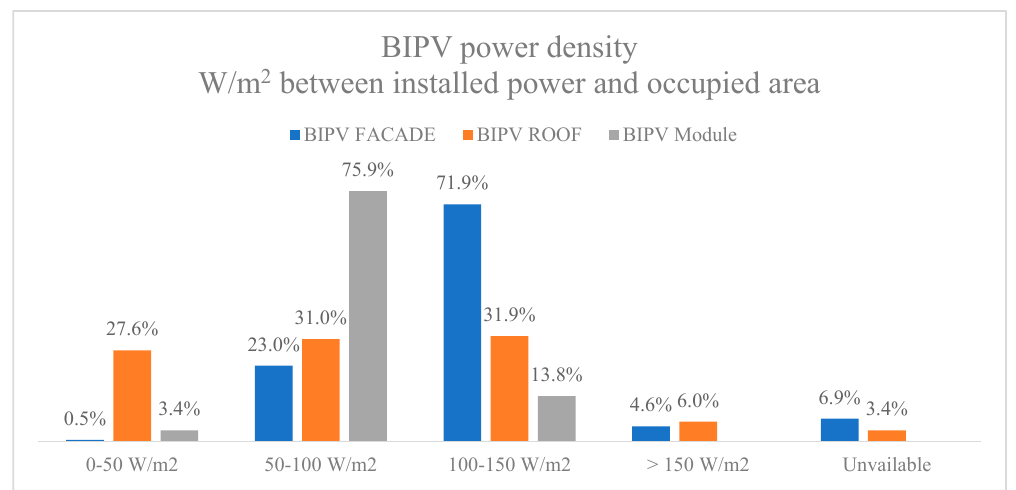
Figure 2. Power density (W / m 2 ) BIPV modules by the installation .